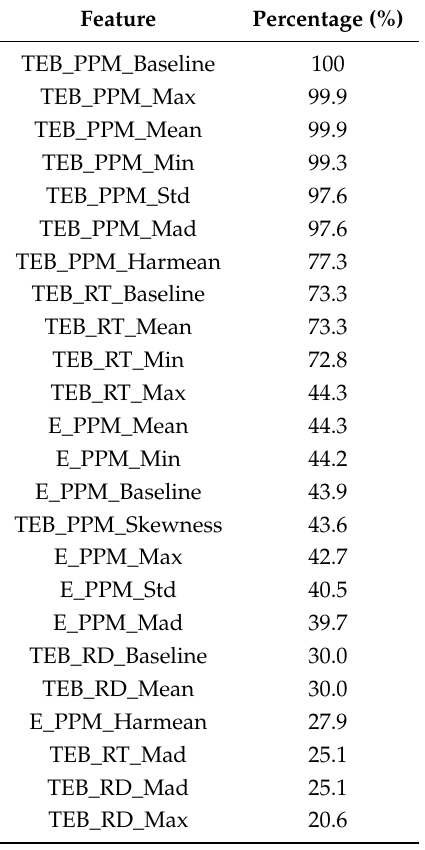
Table 4. Features selected more than 20% in all experiments for SDEO.